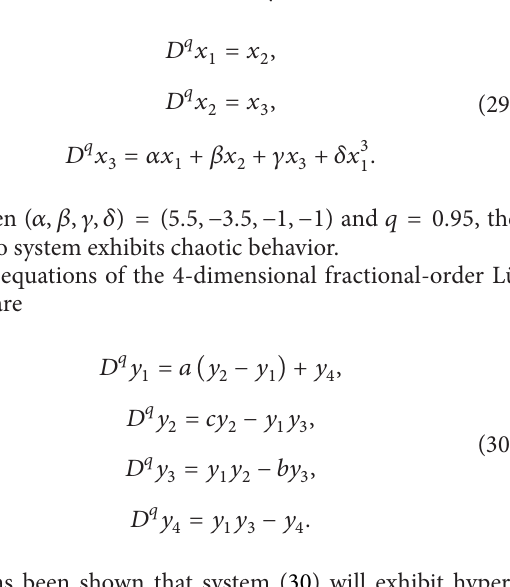
Figure 2: Changing parameters a , b , and c of Chen system (24) with time t